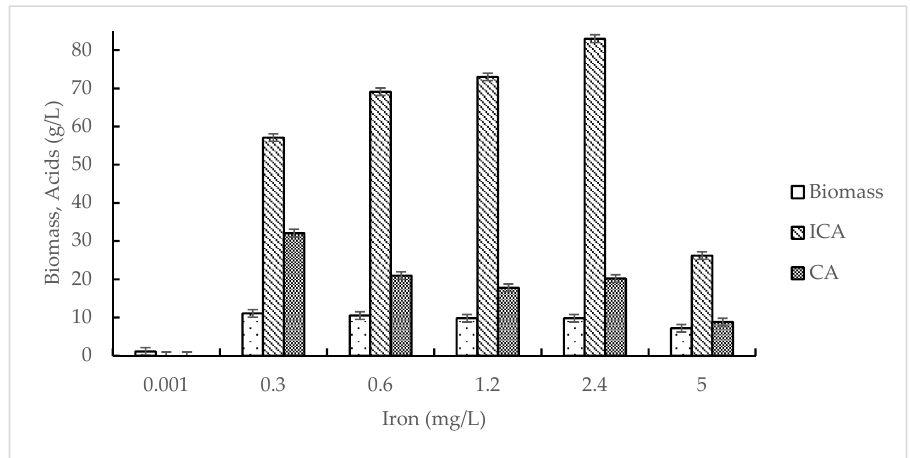
Figure 2. Effect of iron concentration on the growth of Y. lipolytica VKM Y-2373 and production of isocitric acid (ICA) and citric acid (CA). The medium contained 15 mM itaconic